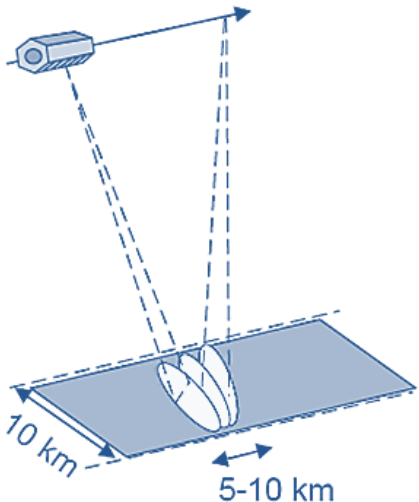
Figure 18. Footprint of the opportunity illuminator (OI) during the acquisition of a spotlight image.